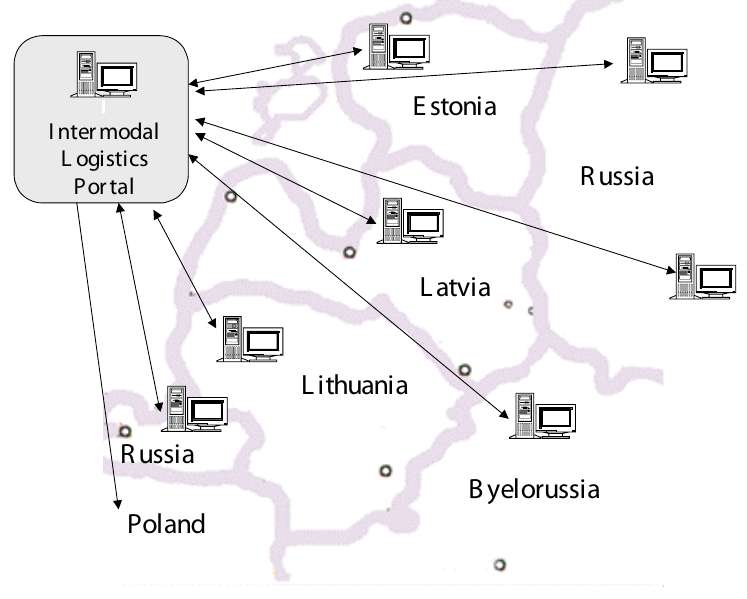
Fig. 3. Network of virtual